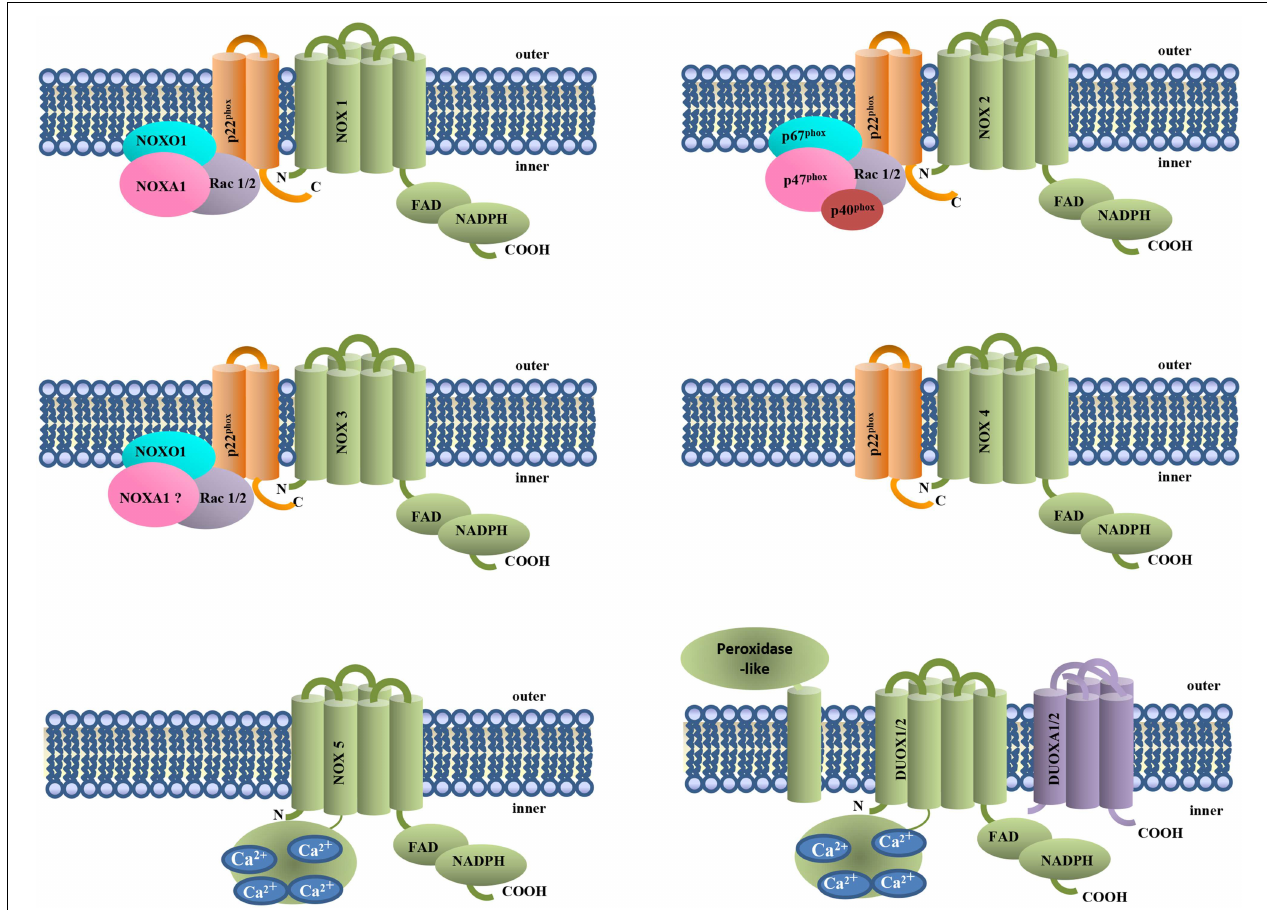
FIGURE 1 | NOX isoforms and regulatory subunits. NOX1-4 are associated to the membrane subunit p22phox. NOX4, NOX5, and DUOX1 and 2 do not require cytosolic subunits for their activity. NOX5 and DUOX1 and 2 activation requires Ca 2 + binding to their EF-hand